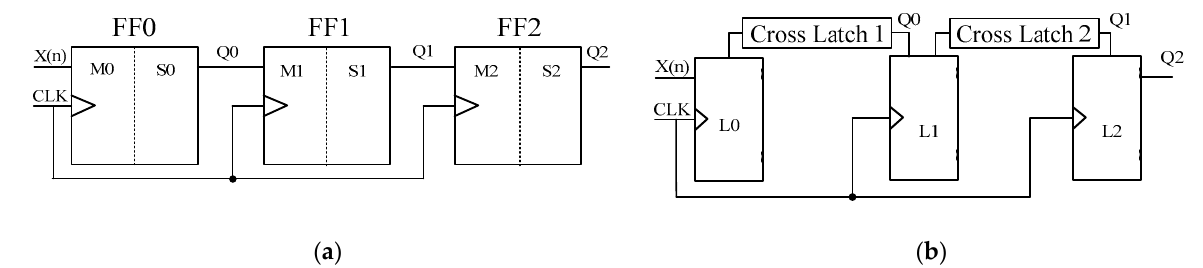
Figure 4. Shift register architectures: ( a ) master–slave design and ( b ) the proposed cross-latch shift register (CLSR) design.